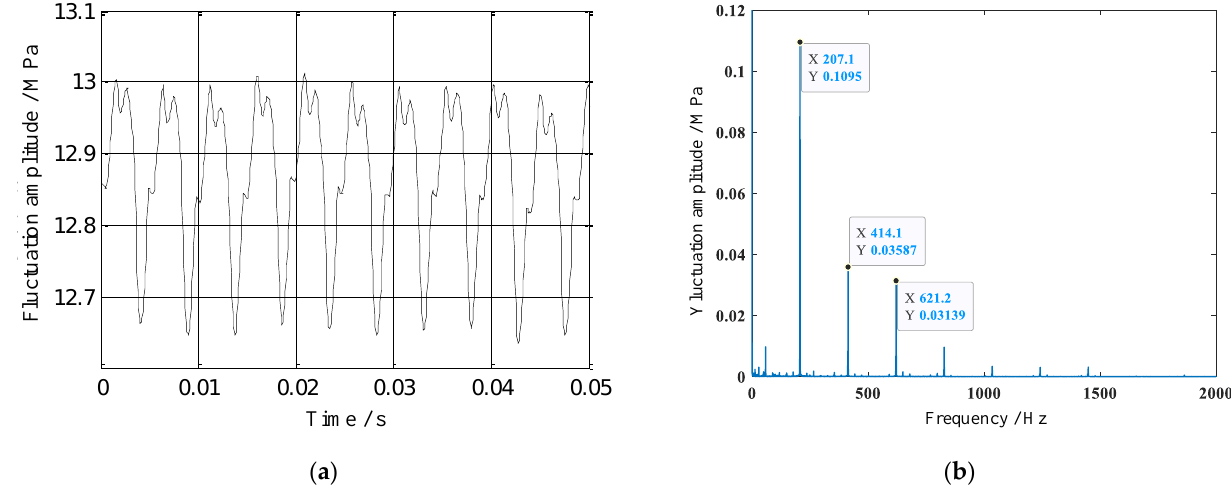
Figure 14. Load pressure ( p 3 = 12.87 MPa) waveform. ( a ) Time domain diagram; ( b ) frequency domain map. It can be seen that the fluid pressure pulsation curve measured at the outlet of the pump showed periodic changes during a constant motor speed. The fluid pressure pulsa- tion curve contained multiple harmonic components in a wide frequency range, and as the load pressure of the hydraulic system increased, the amplitude of the fluid pressure pulsation at the outlet of the pump source increased, which had the most significant im- pact on the amplitude of the fundamental frequency. The conclusions drawn from the experiment were basically consistent with the simulation results. 6.2. Comparative Analysis of the Fluid Pressure Pulsation Experiment and Simulation Under the same load pressure level p 1 = 4.375 MPa, the pump source fluid pressure pulsation was simulated and experimentally tested, and the fluid pressure pulsation waveform curves were compared and analyzed, as shown in Figure 15.